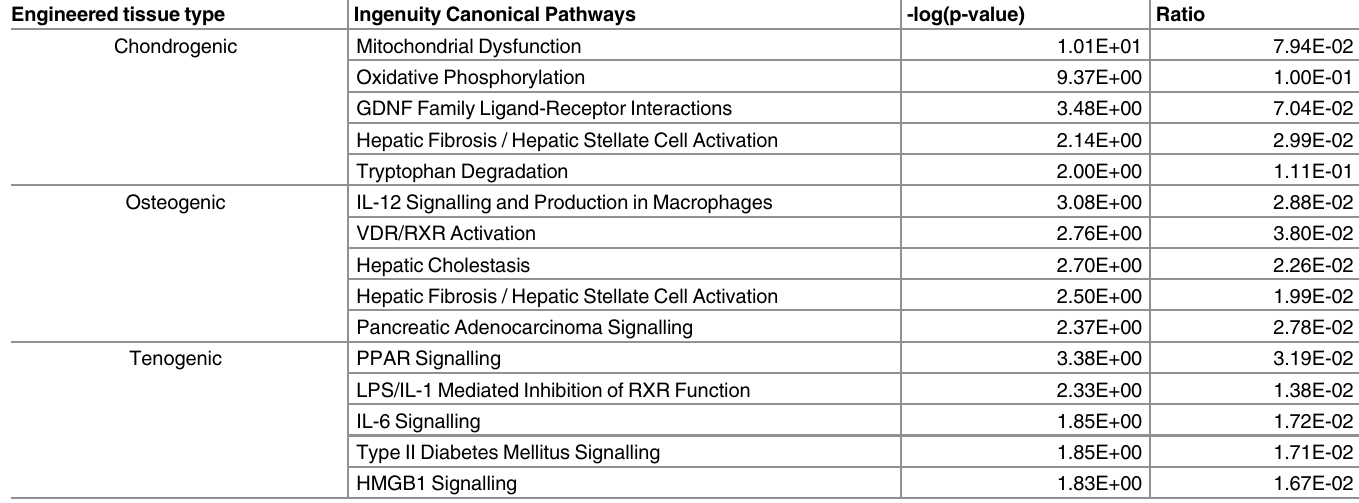
Table 6. The top canonical pathways. Pathways from the IPA knowledge base that involve DE (adjusted P < 0.05 and 1.4 log 2 fold change) protein coding genes differentially expressed in tissues derived from young compared to old MSCs; chondrogenic, tenogenic and osteogenic. Engineered tissue